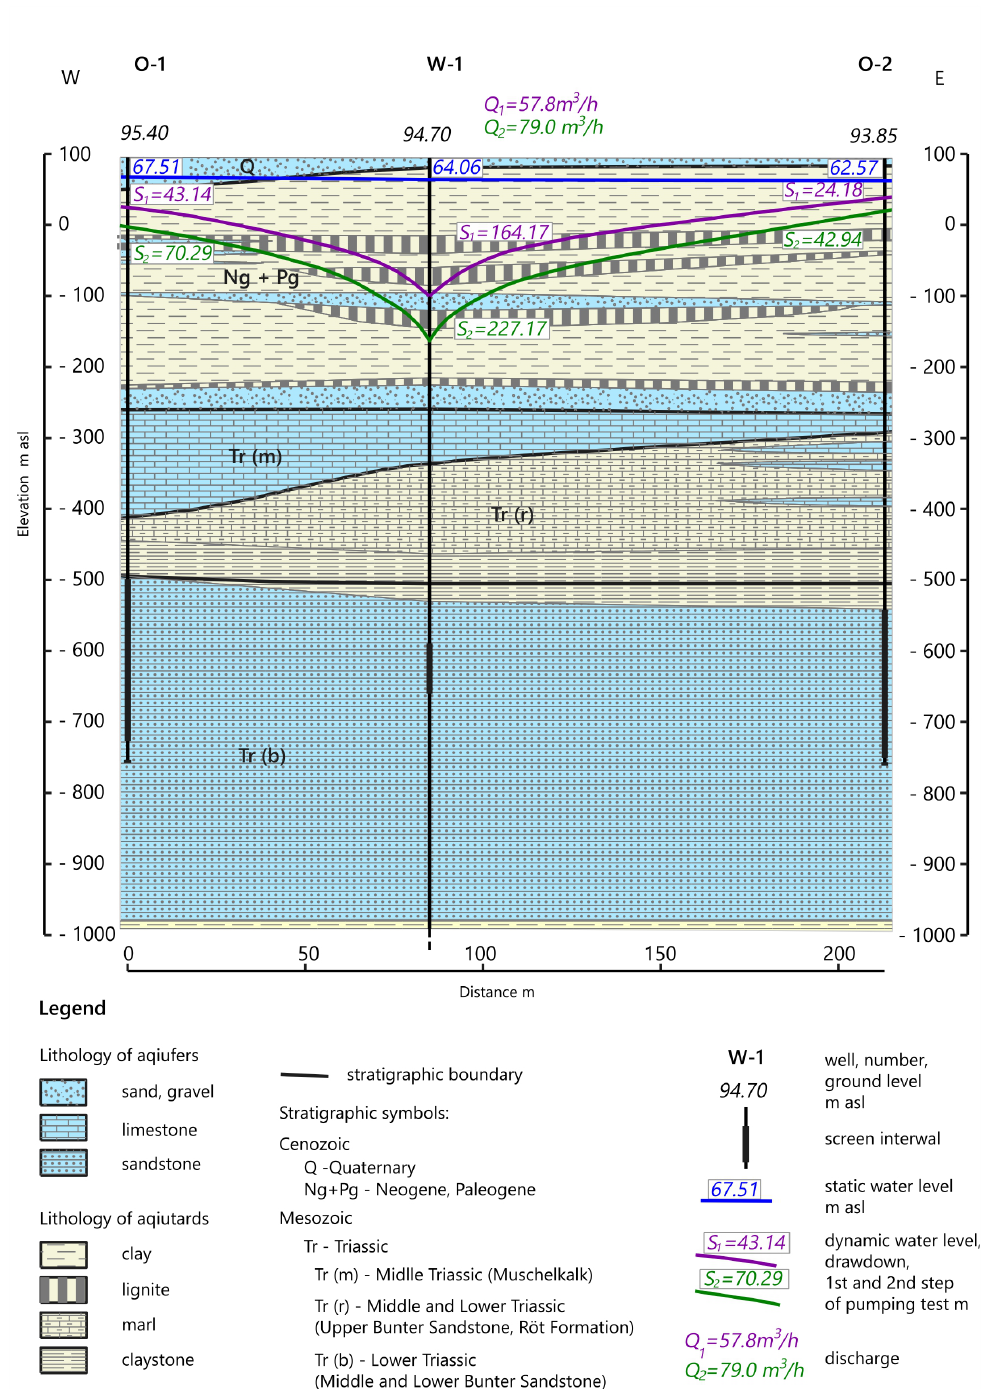
Figure 4. Scheme of hydrogeological conditions of the pumping test area. The Neogene–Paleogene water-bearing horizon includes water in sandy and sandy- gravel layers within isolating layers: clay, silt, and brown coal. Three water-bearing horizons can be distinguished within this horizon: over-coal (Pliocene and upper Miocene), inter-coal (middle and lower Miocene), and under-coal (Oligocene). These three levels of the Neogene–Pliocene aquifer may have hydraulic connectivity locally. The subject of the presented research, the Triassic aquifer, is distinguished by an aquifer of shell limestone, upper Bunter sandstone (Röt Formation), and middle and lower Bunter sandstone. The middle and lower Bunter sandstone aquifer’s water occurs in the arkose sandstone,